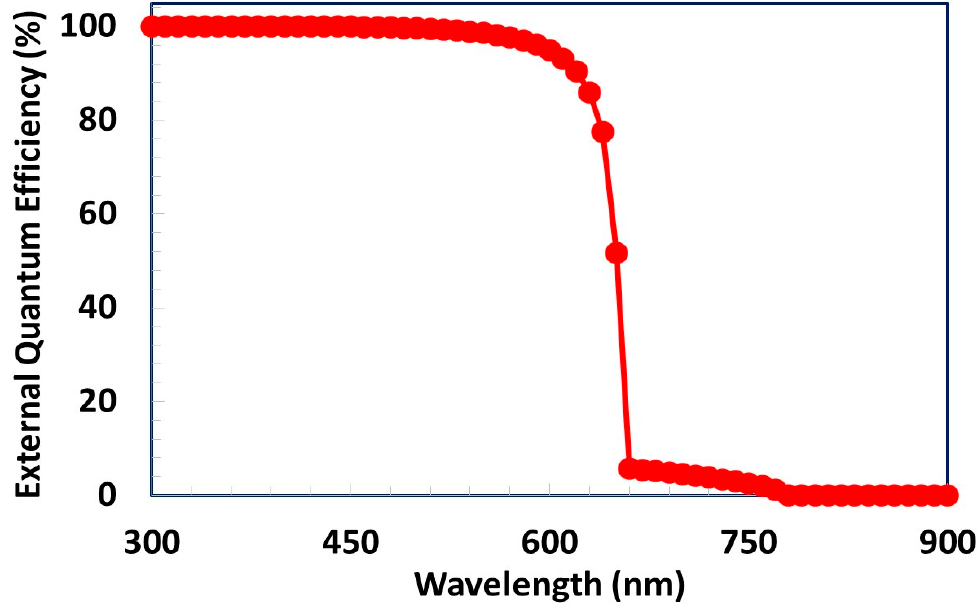
Figure 6. External quantum efficiency response as a function of incident photon wavelength for the proposed solar cell.